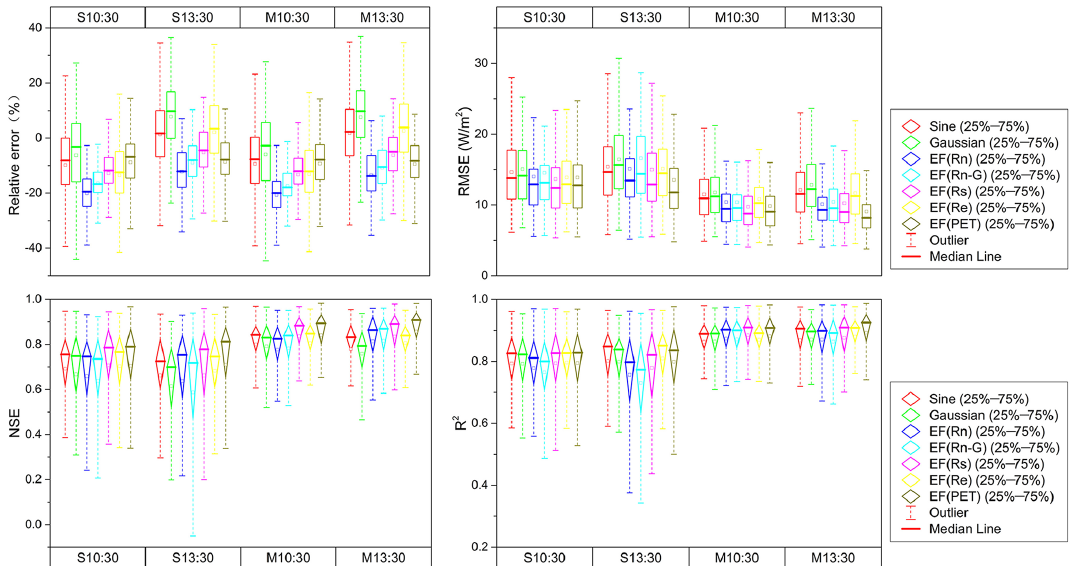
Figure 3. Simulation accuracy of daily LE using seven remote sensing ET upscaling methods, including the sine and Gaussian functions, EF( R n ), EF( R n - G ), EF( R s ), EF( R e ), and EF(PET). Note: S and M represent simulations by a single and average of multi-time values, respectively. For example, S10:30 is simulated by the ratio of a daytime value to a single-time value at 10:30, while M10:30 is simulated by the ratio of a daytime value to the average of three-time values at 10:00, 10:30, and 11:00.